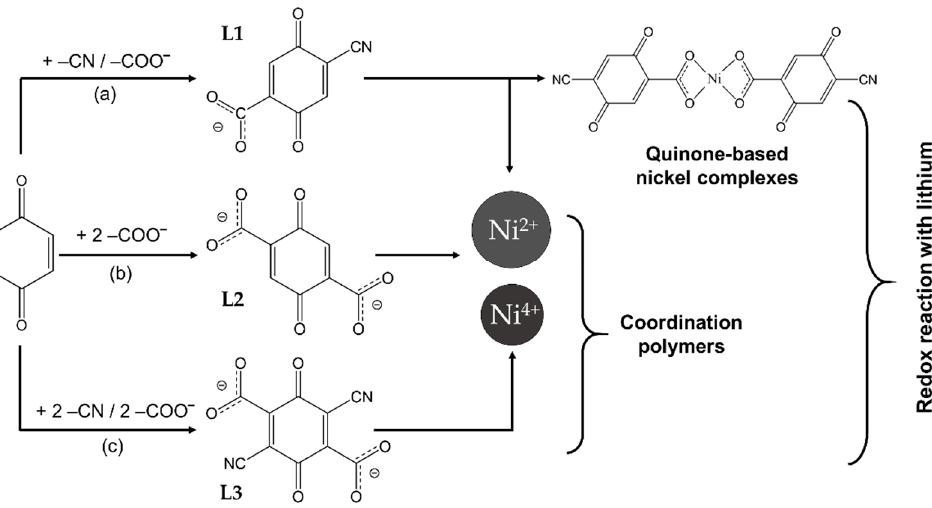
Figure 1. Schematic representation of the designed constructs and the study objectives: 1,4-benzoquinone functionalized with ( a ) a –COO¯ and a -C ≡ N group (L1) to be used as a ligand in complexes with Ni(II) and Ni(IV); ( b ) two –COO¯ groups (L2) or ( c ) two –COO¯ and two -C ≡ N groups (L3), to be used as ligands in coordination polymers with Ni(II) and Ni(IV); the assemblies comprising Ni(IV) are neutralized by Cl¯ ions.